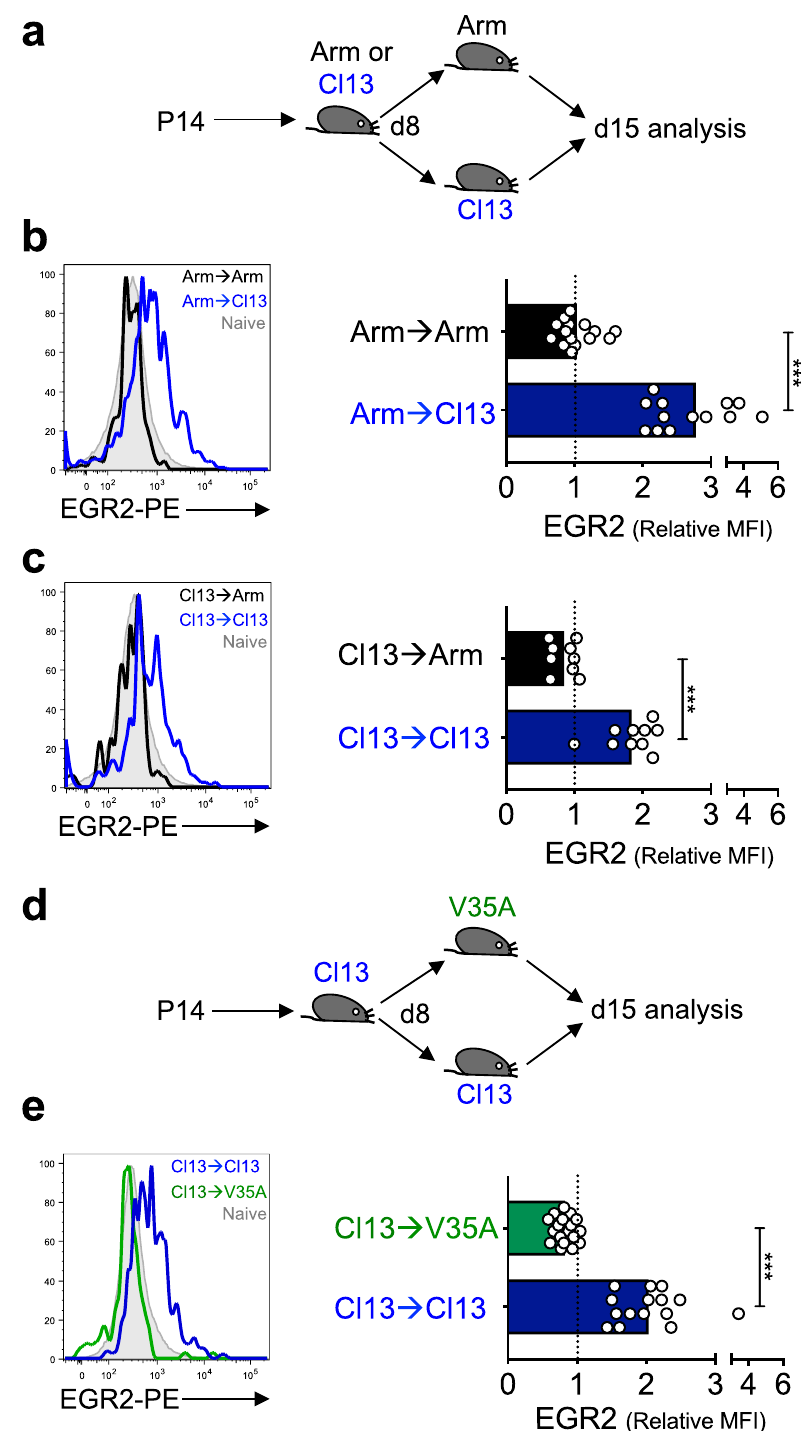
Fig. 2 EGR2 expression is maintained by chronic antigen. a Experiment outline for b , c . 2 × 10 3 CD45.1 + P14 cells were transferred into B6 mice subsequently infected with LCMV-Arm or LCMV-Cl13. On day 8 p.i., splenocytes were isolated and the equivalent of 5 × 10 5 P14 cells were transferred into LCMV-Cl13 or LCMV-Arm infection-matched B6 mice. Seven days later (day 15 p.i.), EGR2 protein levels were assessed within the transferred P14 cells. b , c EGR2 levels within cells transferred from LCMV-Arm ( b ) or LCMV-Cl13 ( c ) donors into Arm or Cl13 infected recipients. Left histograms show representative plots, with naive CD44 lo PD-1 lo cells from Cl13 infected mice also shown in grey. Right graphs show EGR2 MFI relative to the above naive population. n = 13 (top) and 15 (bottom) ( b ), and n = 10 (top) and 9 (bottom) ( c ), mice per group from 2 – 3 independent experiments. d Experiment outline for e . Experiment was conducted as in a except that P14 cells derived from Cl13 infected donors were transferred into recipients infected with wild-type Cl13 or GP V35A mutant Cl13. e EGR2 levels within cells transferred from Cl13 donors into Cl13 or V35A recipients. Plots and data representation is as in b , c . n = 15 (top) and 18 (bottom) mice per group from three independent experiments. p -values were calculated using a two-tailed unpaired T test ( c ) or two- tailed Mann – Whitney test ( b , e ). For all indicated signi fi cant differences p < 0.0001. *** p < 0.001.